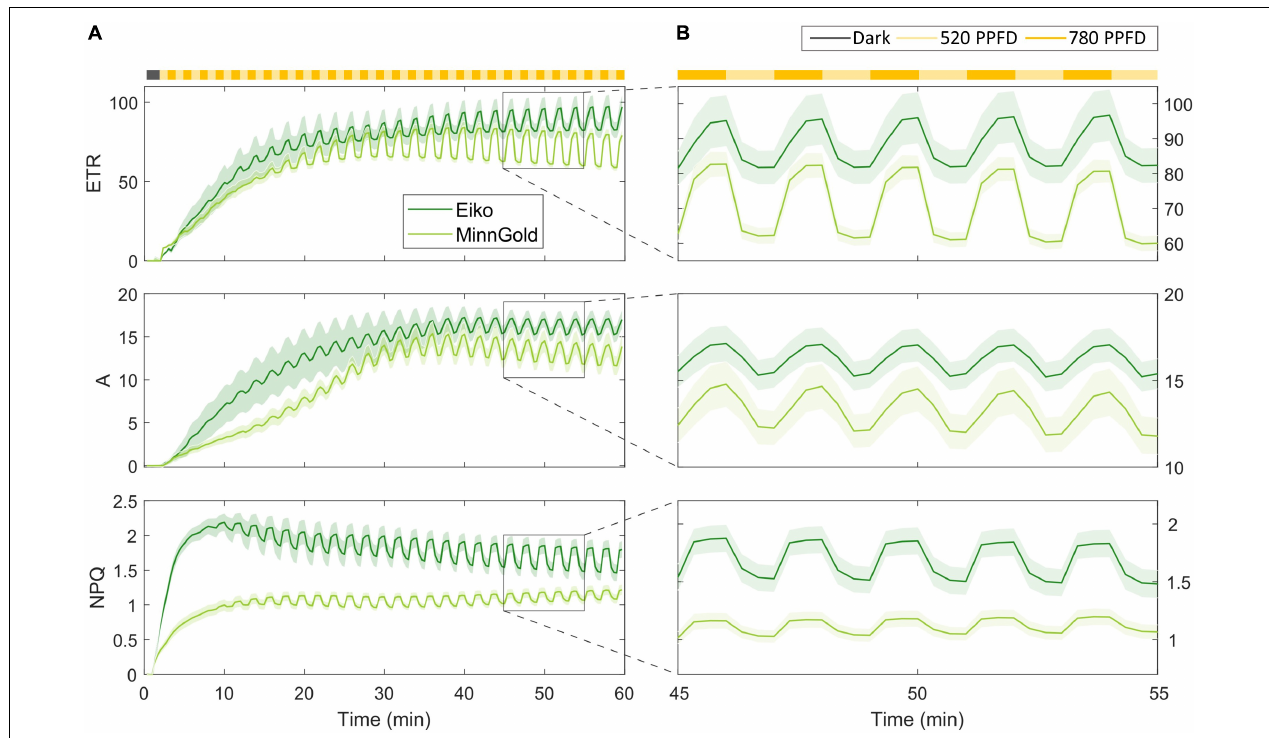
FIGURE 2 | Fluorescence data coupled with gas exchange data in the fluctuating light regime for the two varieties Eiko (indicated in dark green) and MinnGold (indicated in light green). The light intensity was fluctuating every min from 780 (indicated in dark yellow) to 520 µ mol m - 2 s - 1 (indicated in light yellow). (A) Data taken from all the experimental periods (60 min) (B). Focus on the fluctuations from 45 to 55